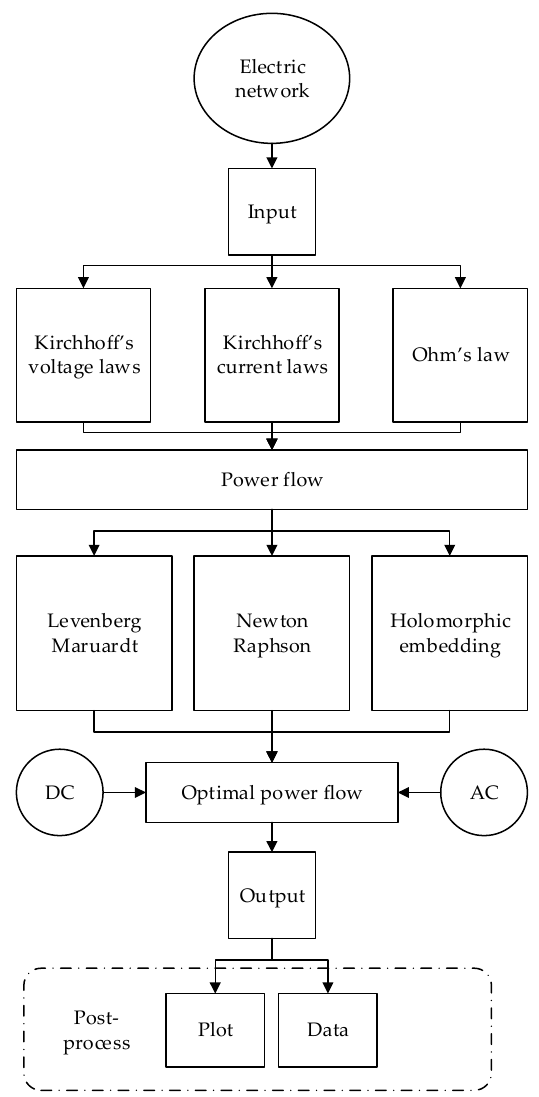
Figure 2. Electrical network architecture .